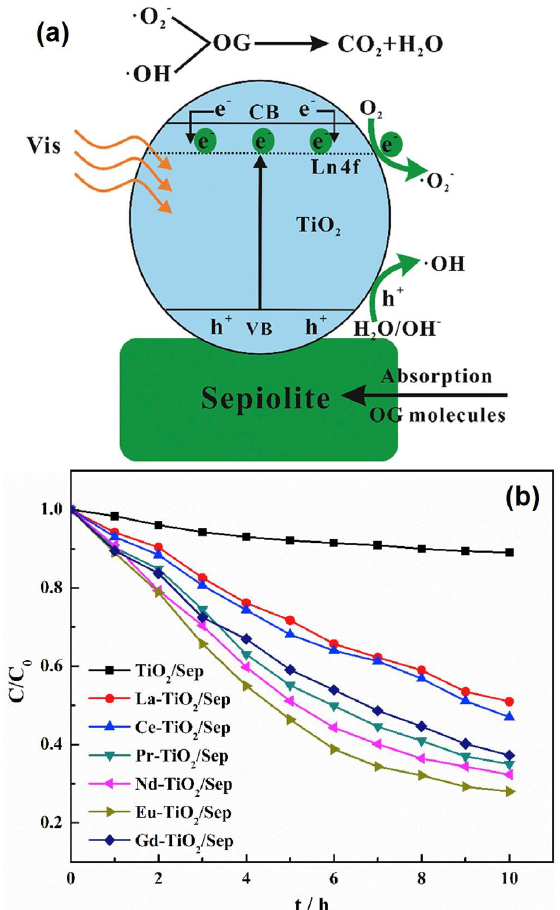
Figure 7. ( a ) Proposed visible-light-induced photocatalytic mechanism over the RE–TiO 2 /Sep nanocomposites and ( b ) photocatalytic degradation rate of orange G under visible light irradiation for 10 h over various types of photocatalysts. Reproduced from [121] . Copyright (2018), Elsevier.